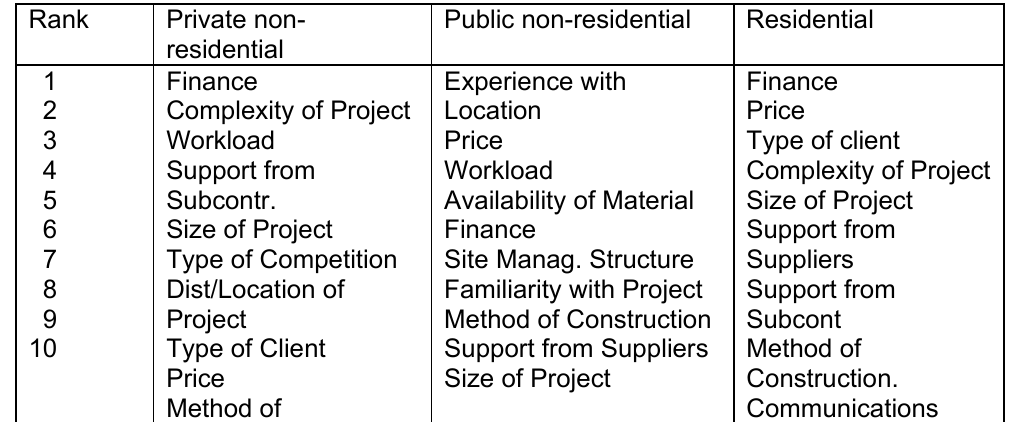
Fig. 2 Number of firms operating in individual and overlapping markets